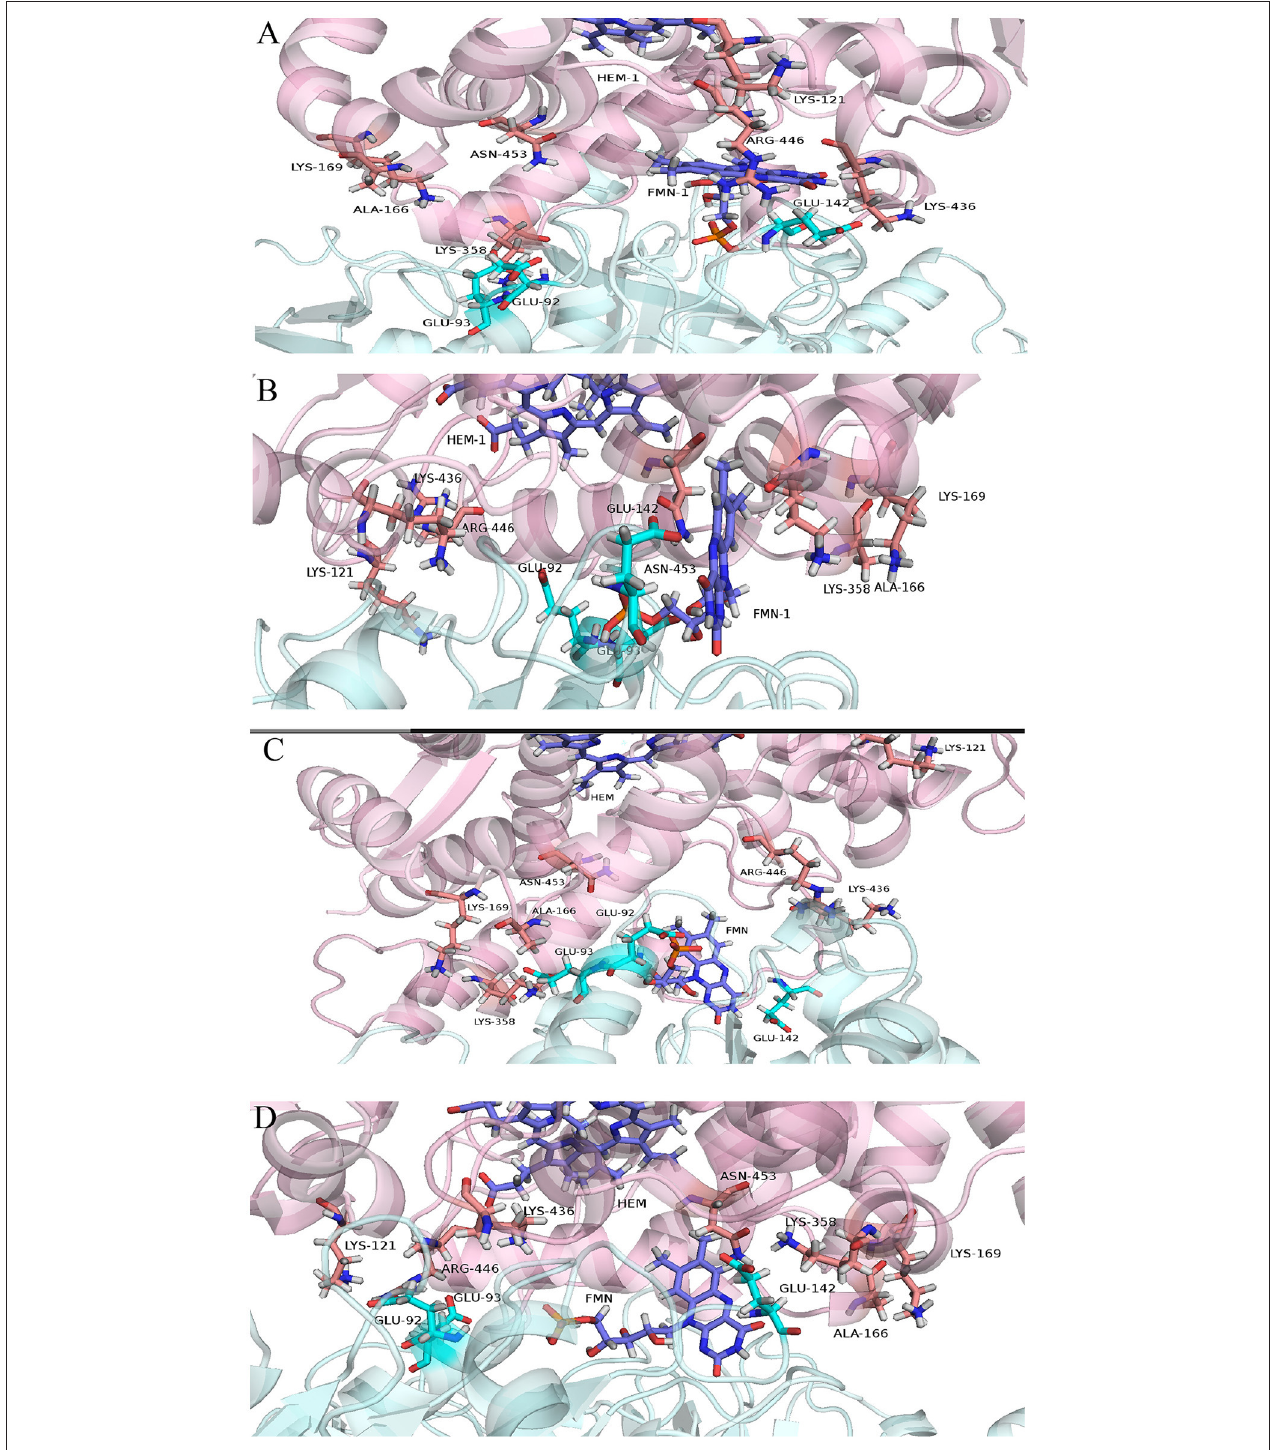
FIGURE 3 | Cartoon representing predicted CYP51A1 residues interacting with POR (depicted in cyan color) in (A) wild type, (B) R277L variant, (C) R431H variant, and (D) D152G variant. ( A–D are depicted in pink color).